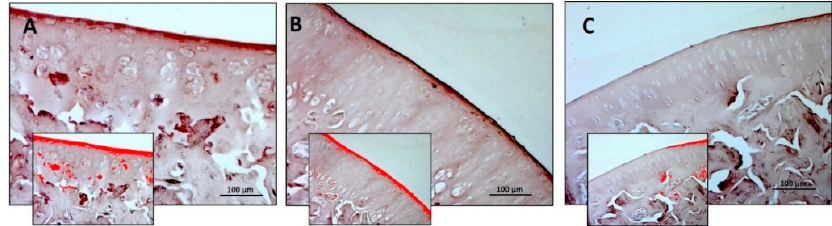
Figure 4. Collagen II (Col II) immunohistochemical evaluation in the articular cartilage through computerised densitometric measurements and image analysis. ( A ) R group; ( B ) R-DS group; ( C ) R- DR group. In inserts are the image analyses by the software in which the red colour represents brown staining (immune complexes labelled with chromogen). For details, see the text. ( A – C ) Objective lens, 10; scale bars: 100 μ m. These are the most representative images of articular cartilage from rats of each group (R, R-DS and R-DR). Table 5. COL II Immunostaining—Articular cartilage.